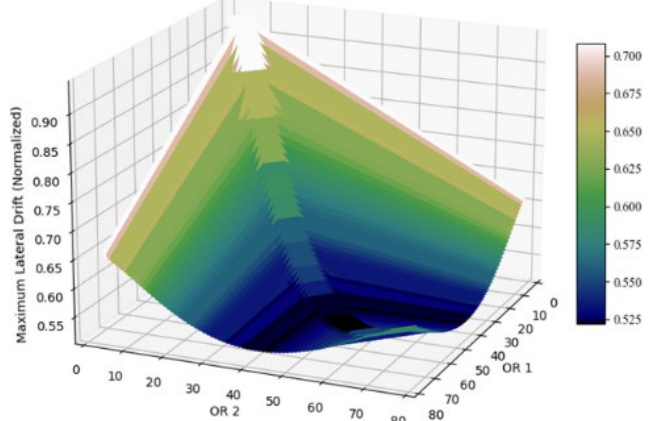
Figure 10. Exhaustive search with 2 ORs (Objective: MLD)